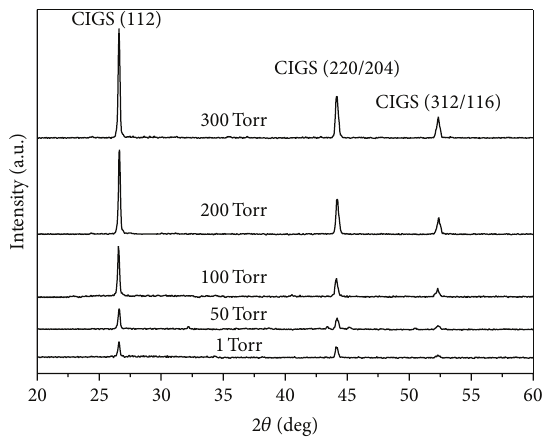
Figure 5: XRD patterns of the CIGS films, selenized using different Ar